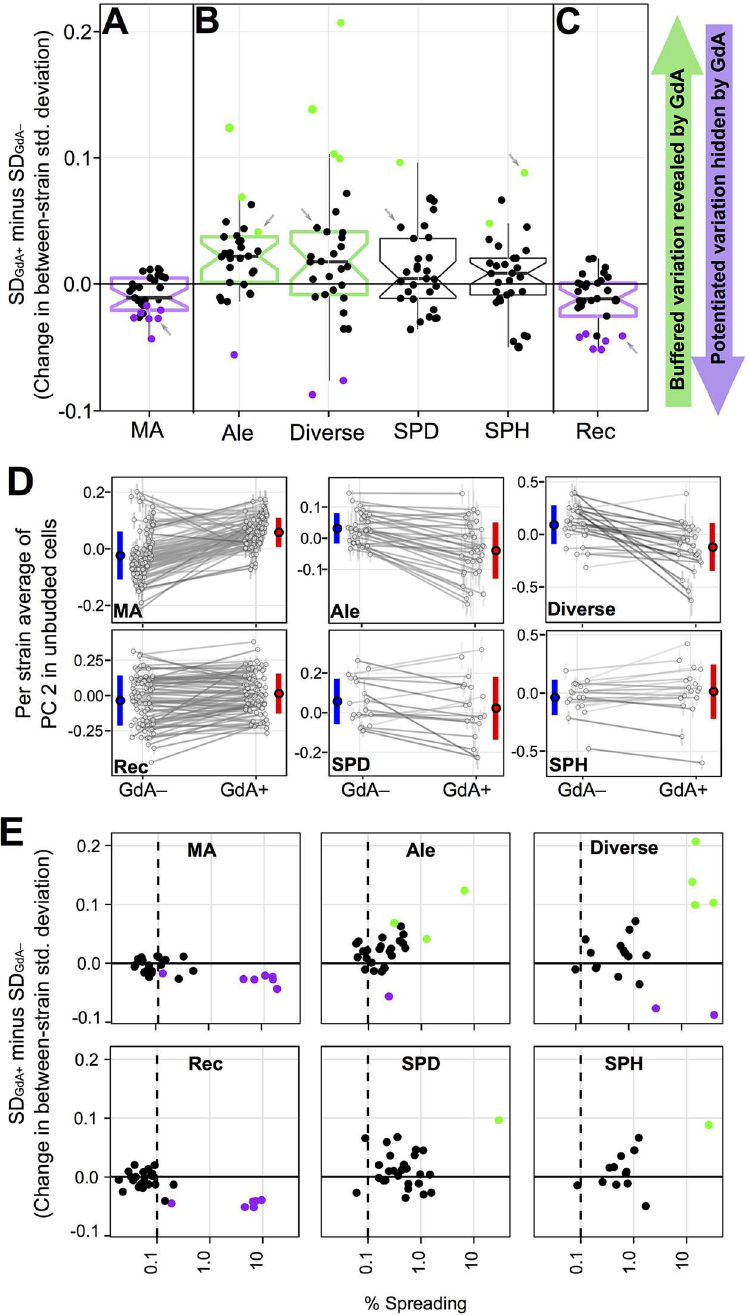
Fig 5. GdA’s effect on morphological variation differs in yeast strains possessing spontaneous mutations or recombinations, as compared to natural yeast isolates. In (A–C), each point is plotted to represent between-strain morphological variation (standard deviation)in the GdA+ conditionminus that in the GdA − condition;colored dots represent significant variance increases (green) or decreases (purple) in GdA+ versus GdA − (significance defined as when the 95% credible interval surroundingthe differencedoes not overlapzero). Boxplots summarize the distribution across all 29 PCs for each strain collection, displaying the median(center line), interquartilerange (IQR) (upper and lower hinges), highest value within 1.5 × IQR (whiskers), and roughly a 95% confidence interval around the median calculated as 1.58 × IQR / (notches). If this confidence interval does not overlap zero, boxplots are colored green when Hsp90-inhibition tends to reveal variation and purple when inhibitiontends to hide variation. AlthoughPCs differ in the